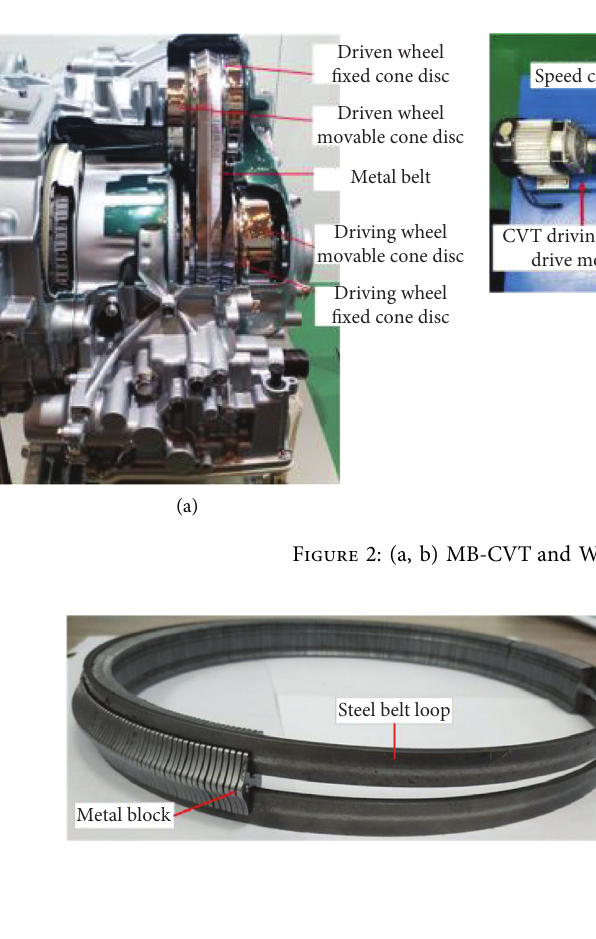
Figure 1: Application of continuous and discontinuous contact of wire rope with pulley and metal block. (a) Continuous contact between wire rope and hoist pulley. (b) Discontinuous contact between wire rope and multiple metal blocks for CVT.